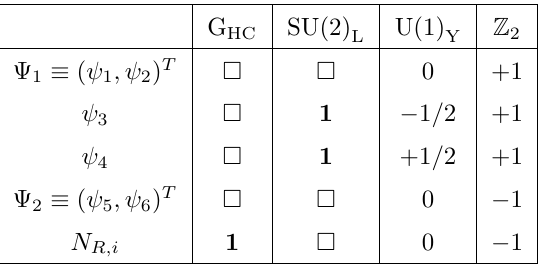
Table 1 . The hyper-fermions and the right-handed neutrinos in the SU(6)/Sp(6) template model labelled with their representations of G HC × SU (2) L × U (1) Y and parity under the Z 2 symmetry. The index i = 1 , 2 , 3 represents the generation number of the